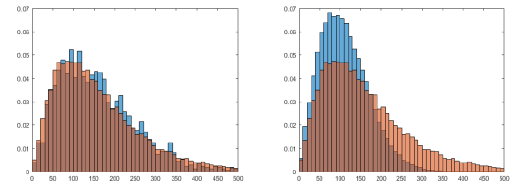
Figure 3. Gray value histogram of real debris amplitude samples (orange) in comparison to vegetation (left) and gravel (right).